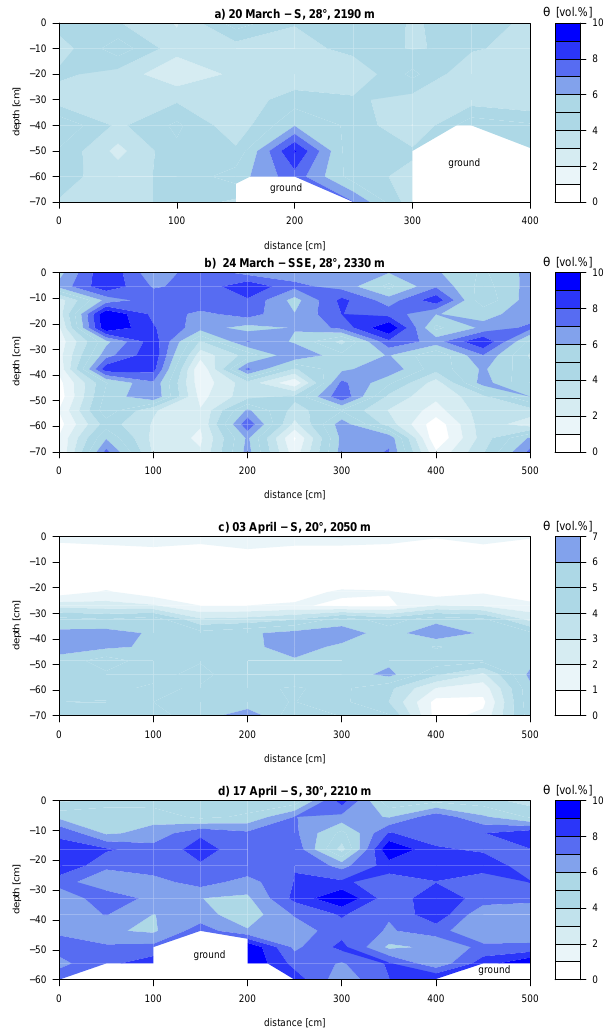
Fig. 12. Evolution of snow wetness during melting from 20 March Fig. 11. Evolution of snow wetness during melting from 20 March till 17 April 2010. Contour plots showing cross-sections of snow till 17 April 2010 on southerly aspect slopes at similar altitudes. wetness ( θ ) to a depth of up to 70cm over 5m wide areas across the Contour plots showing cross-sections of snow wetness ( θ ) to a depth slope. All observations were observed in shallow snowpack areas at of up to 70 cm over 5 m wide areas across the slope. All observa- similar elevations (2000–2300m) in southerly aspect slopes (SE, S, tions were observed in shallow snowpack areas at similar elevations SW). θ , measured with the Snow Fork, is corrected by − 0.8vol.% (2000 - 2300 m) in southerly aspect slopes (SE, S, SW). θ , measured (this corresponds to the median offset in dry snow). θ -values greater with the Snow Fork, is corrected by -0.8 vol.% (this corresponds to than 10vol.% are shown as the median offset in dry snow). θ -values greater than 10 vol.% are shown as 10 vol.%.